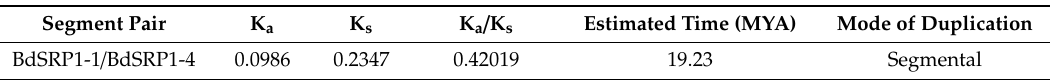
Table 3. The K a and K s values and estimated divergence time for segmentally duplicated BdSRP genes. Segment Pair